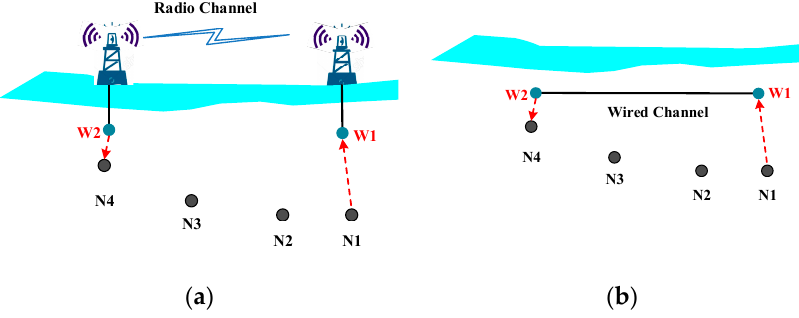
Figure 9. Two methods of wormhole attack; ( a ) using radio channel; ( b ) using wired channel.